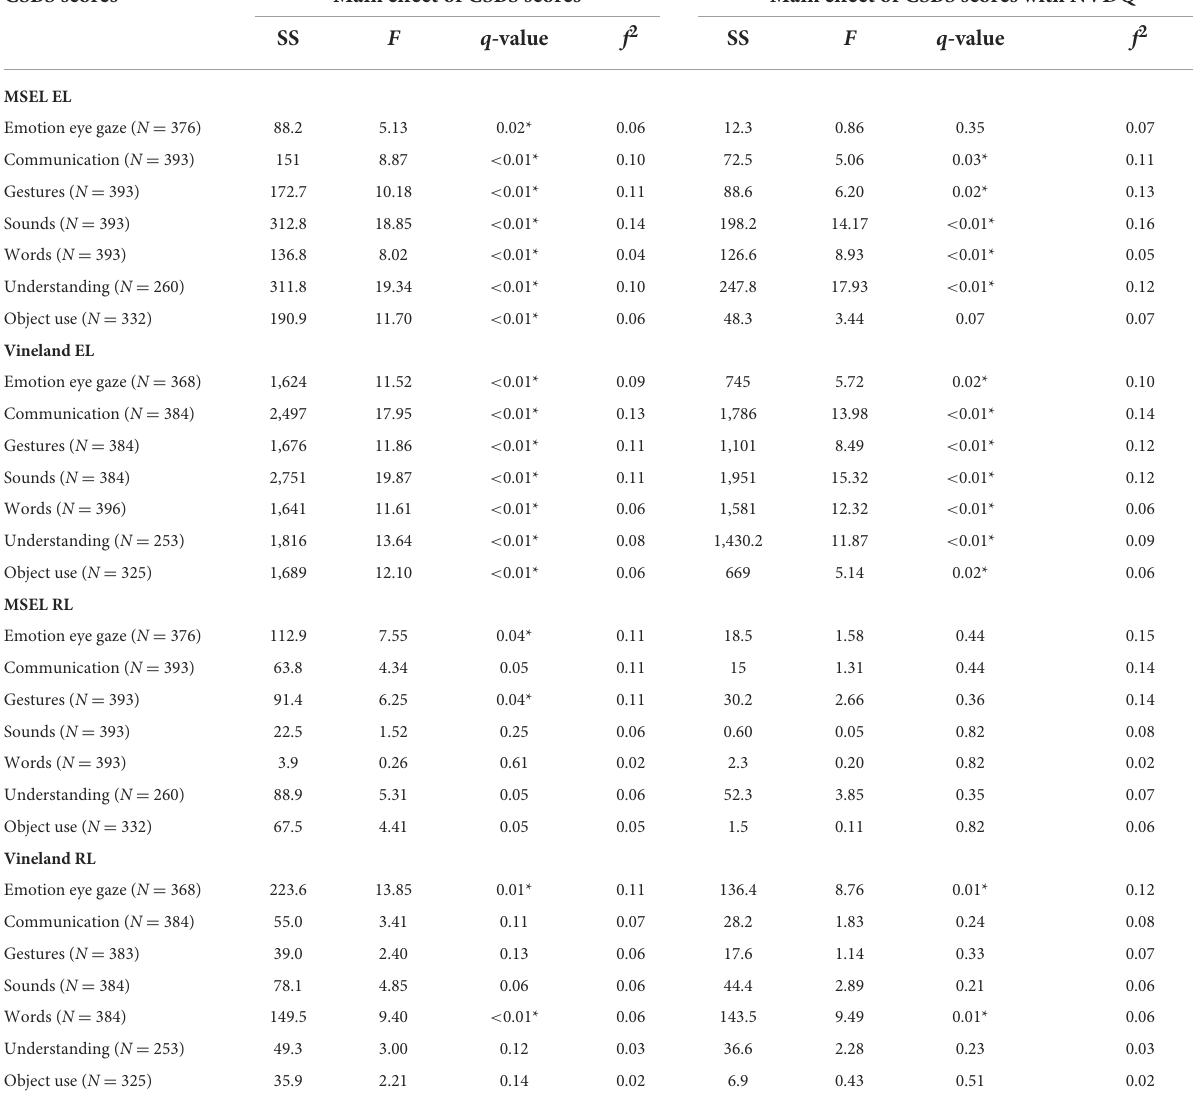
TABLE 5 General liner model exploring main effects of social communication skills measured at 12-months on language abilities measured at 24-months. CSBS scores Main effect of CSBS scores Main effect of CSBS scores with